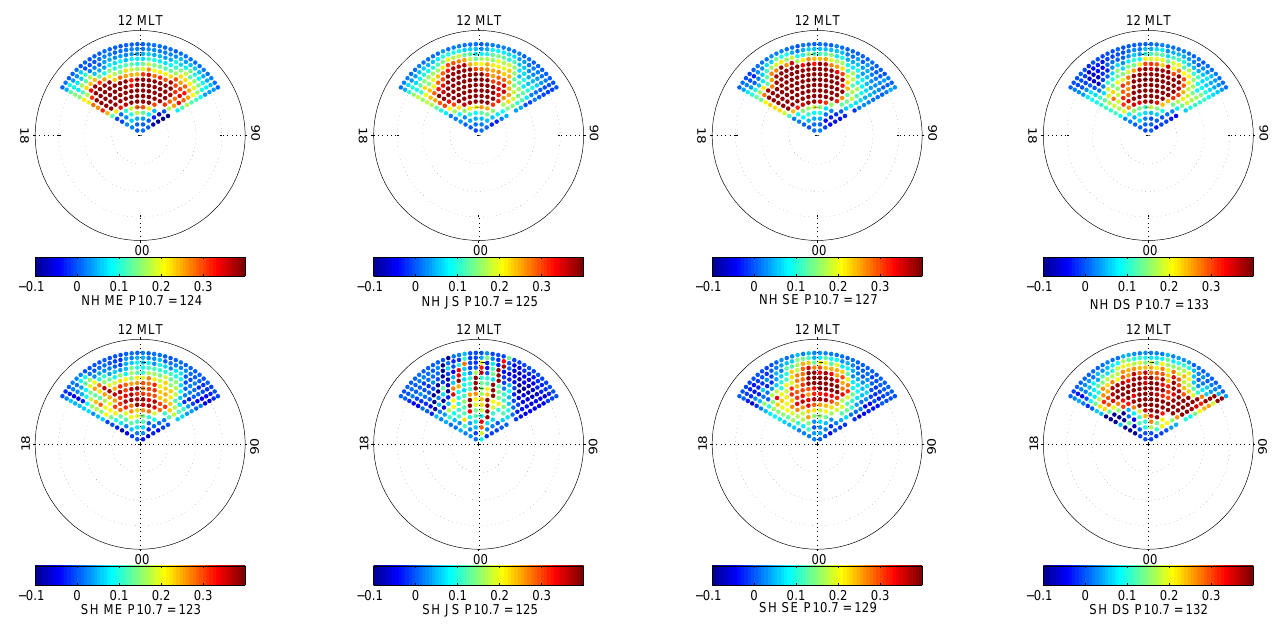
Fig. 5. Seasonal dependence of the density anomaly in the dayside polar region of the northern (upper row) and southern (lower row) hemisphere for March Equinox (ME, first column), June Solstice (JS, second column), September Equinox (SE, third column), and December Solstice (DS, fourth column). Average solar flux values (P10.7) are listed below the plots. orbital altitude, are sorted into a solar flux versus merging electric field